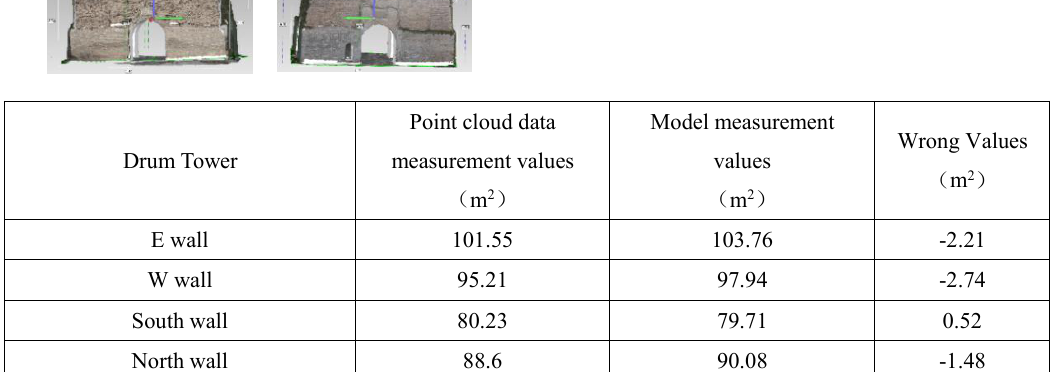
Figure 10. The Drum Tower has a high base (2) the bottom of the drum tower high measuring 9.603 m, 10.025 m, calculate the average 9.814 m high to the bottom of the drum tower, measuring data is shown in figure 10. The point cloud measurement data was compared with the model measurement data, and the difference value was calculated. The comparison results were shown in Table 2. The maximum error value in the table was -2.21 m 2 , and the minimum error value was 0.52 m 2 , which met the engineering requirements. Figure 9 . Basic data amount of the existing Drum Tower model obtained as shown in Table 3 and figure 9.: